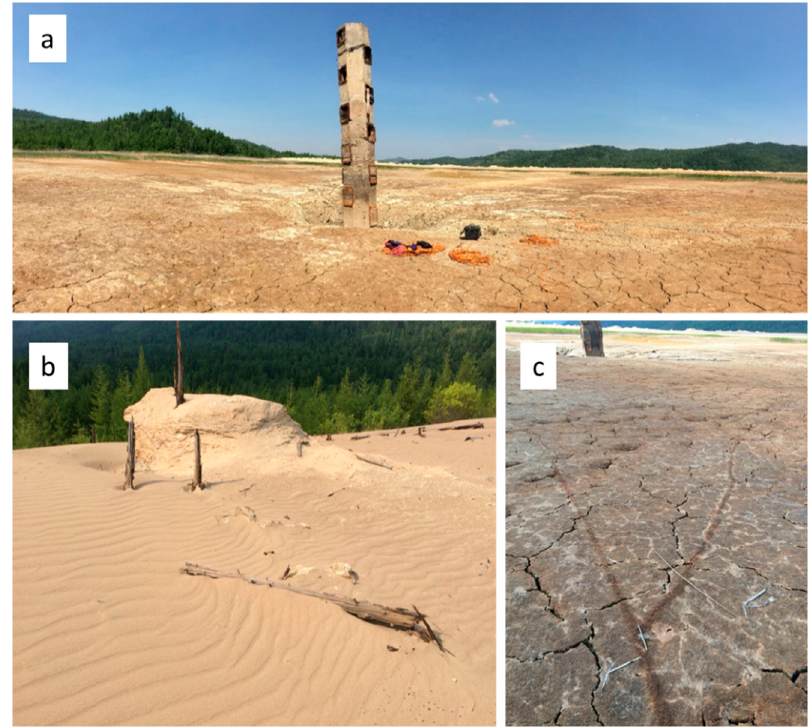
Figure 2. Drainage well on the area of the tailings dump ( a ); aeolian processes at the tailings dam ( b ); shrinkage cracks and pseudomorphoses by frost-breaking cracks on the surface of the tailings dump ( c ).